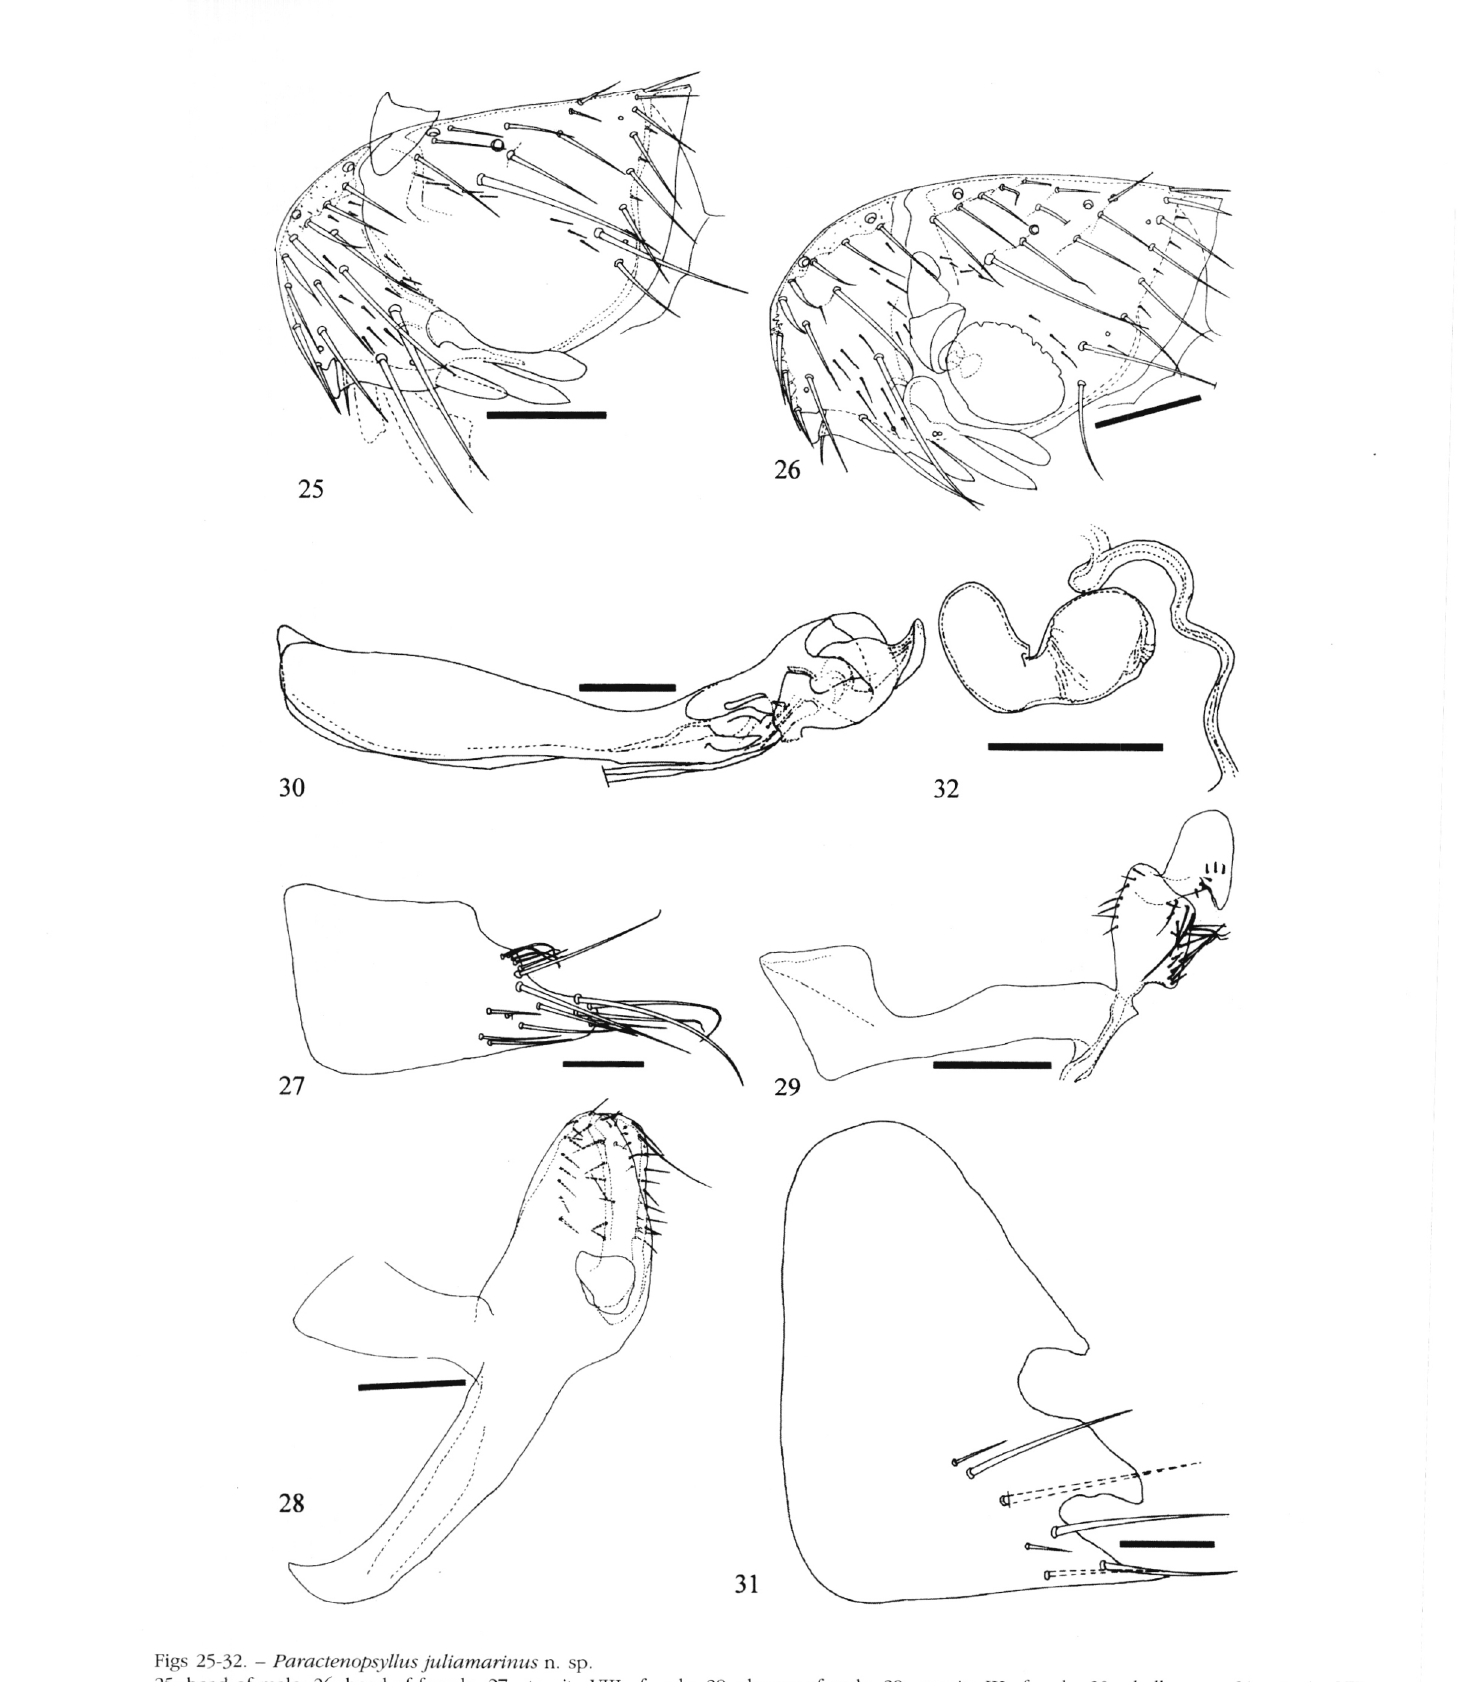
Figs 25-32. - Paractenopsyllus juliamarinus n. sp. 25: head of male; 26: head of female; 27: sternite VIII of male; 28: clasper of male; 29: sternite IX of male; 30: phallosome; 31: sternite VII of female; 32: spermatheca and ductus bursae. All scale bars = 0,1